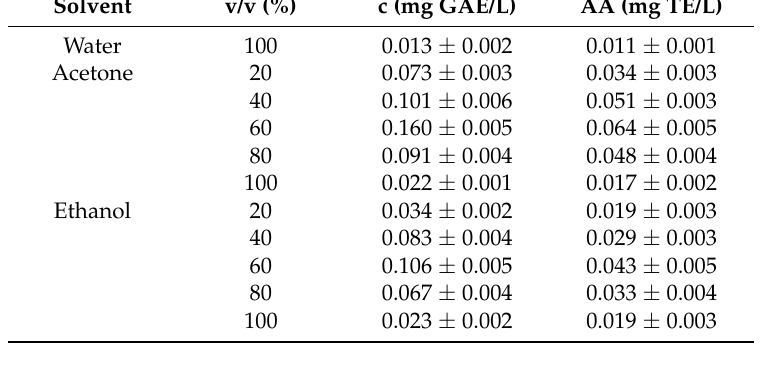
Figure 1. Amount of recovered phenolic compounds per unit weight of dry solid (q) in each extraction stage, with the associated recovery percentages. Table 1. Concentration of phenolic compounds (c) and antioxidant activity (AA) of water–organic solvent extracts from brewers’ spent grain (BSG). Data are expressed as mean ± standard deviation ( n = 3).